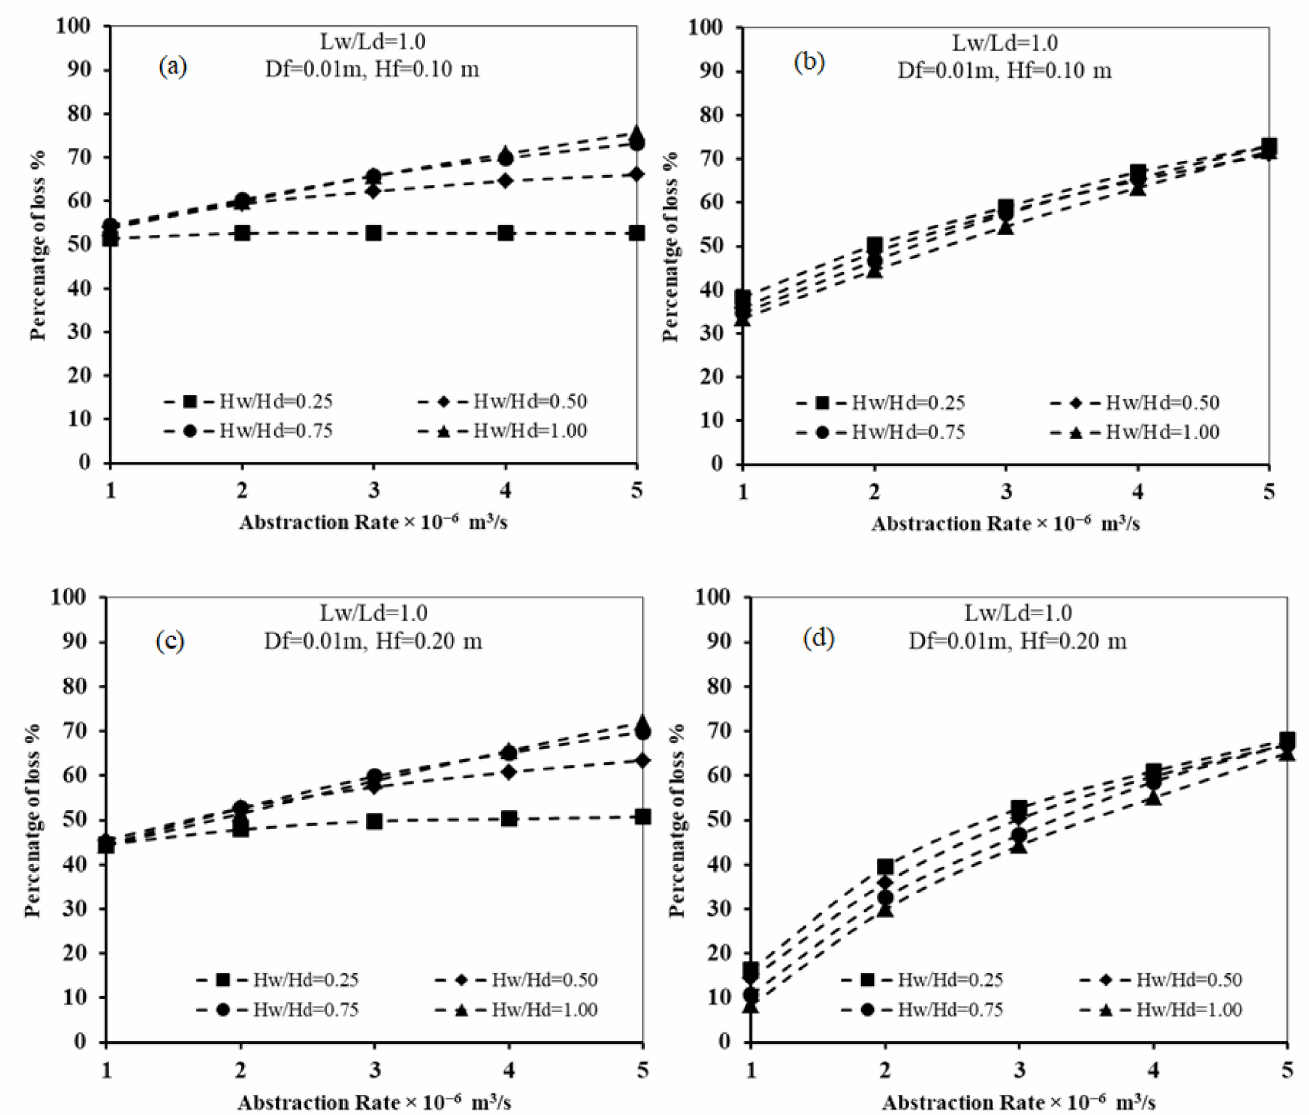
Figure 13. Relation between abstraction rate and loss of subsurface dam effectiveness D F = 0.01 m and L w /L d = 1.0 for different values of subsurface dam location: ( a ) L d = 0.30 m, H f = 0.1 m ( b ) L d = 0.50 m, H f = 0.1 m ( c ) L d = 0.30 m, H f = 0.2 m, and ( d ) L d = 0.50 m, H f = 0.2